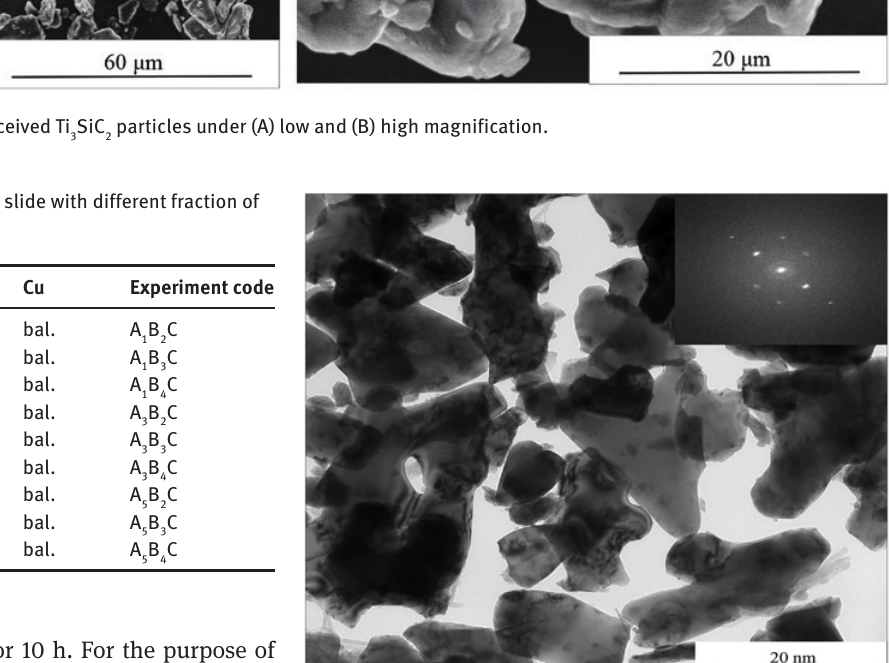
Figure 2: SEM presentation of as-received Ti